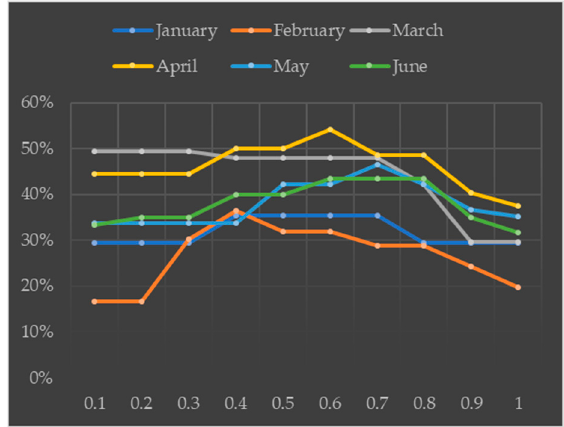
Figure 15. Sensitivity of AnisDM to parameter 𝜂 that weighs location and environmental